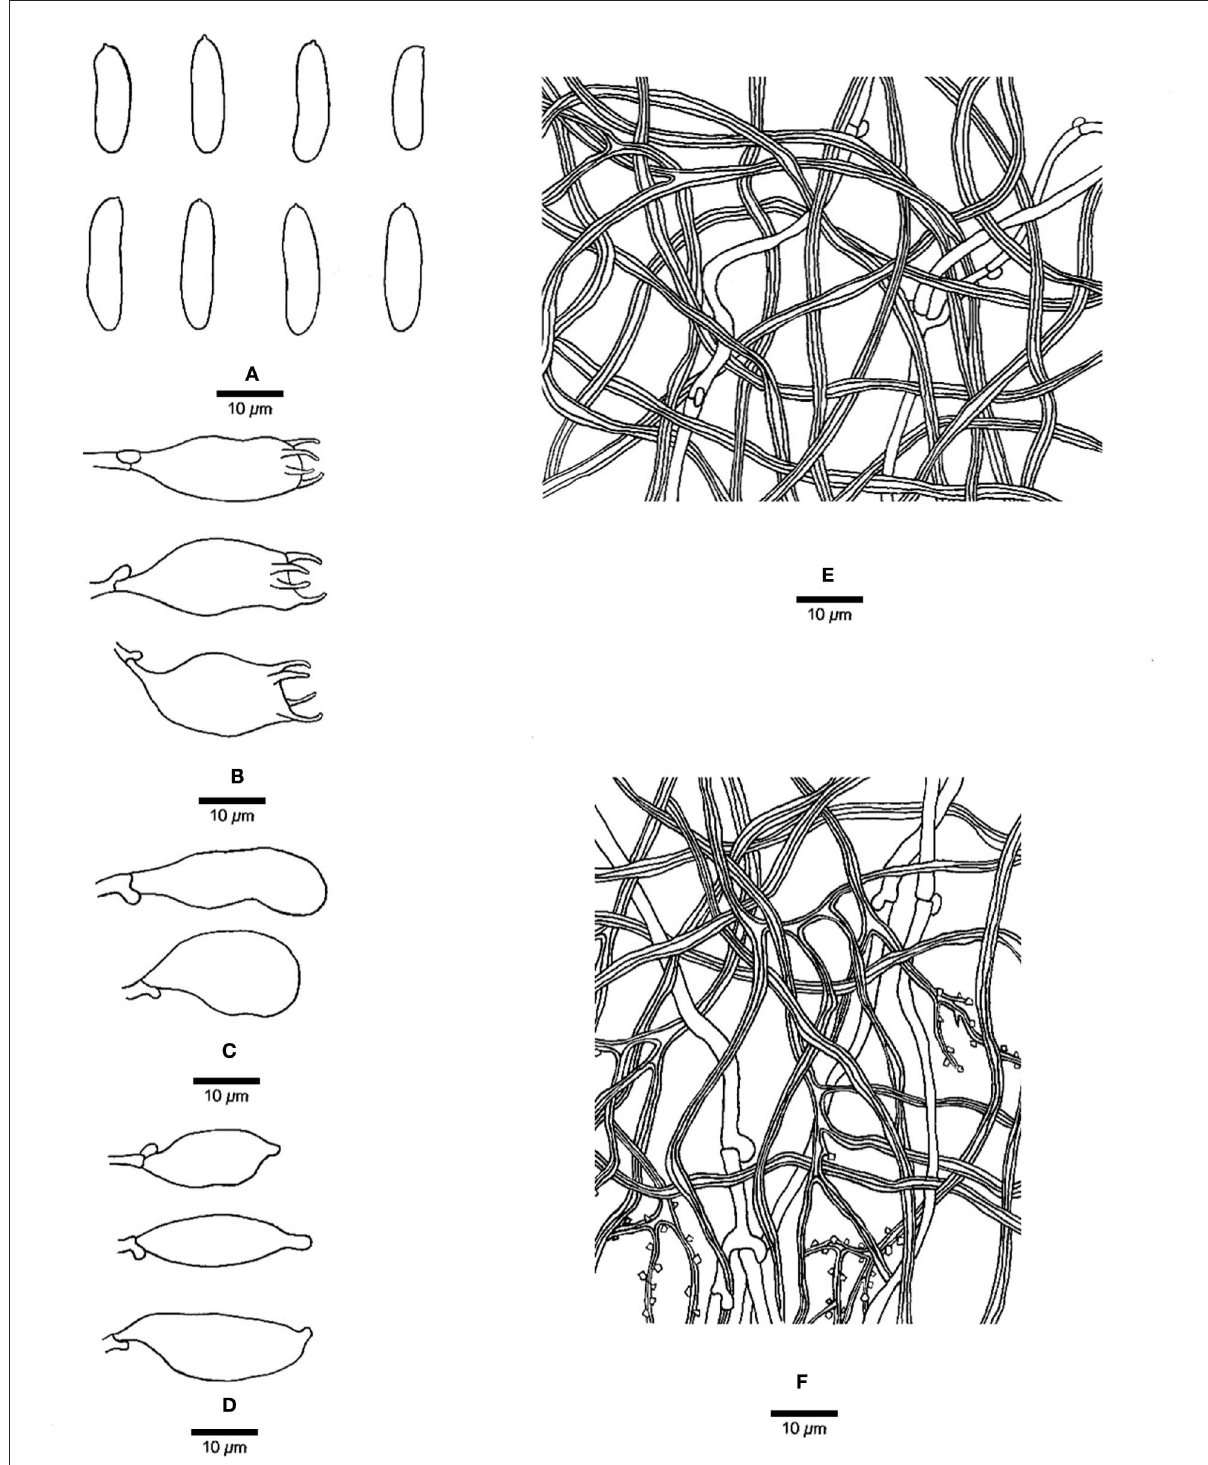
FIGURE3 Microscopic structures of Jorgewrightia austroasiana (drawn from the holotype, Dai 17884). (A) basidiospores, (B) basidia, (C) basidioles, (D) cystidioles, (E) hyphae from subiculum, and (F) hyphae from tube